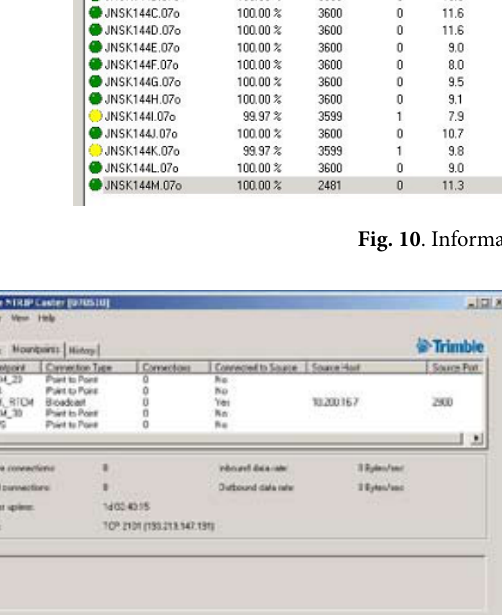
Fig. 13 . GNSS stations at Latvian-Lithuanian border